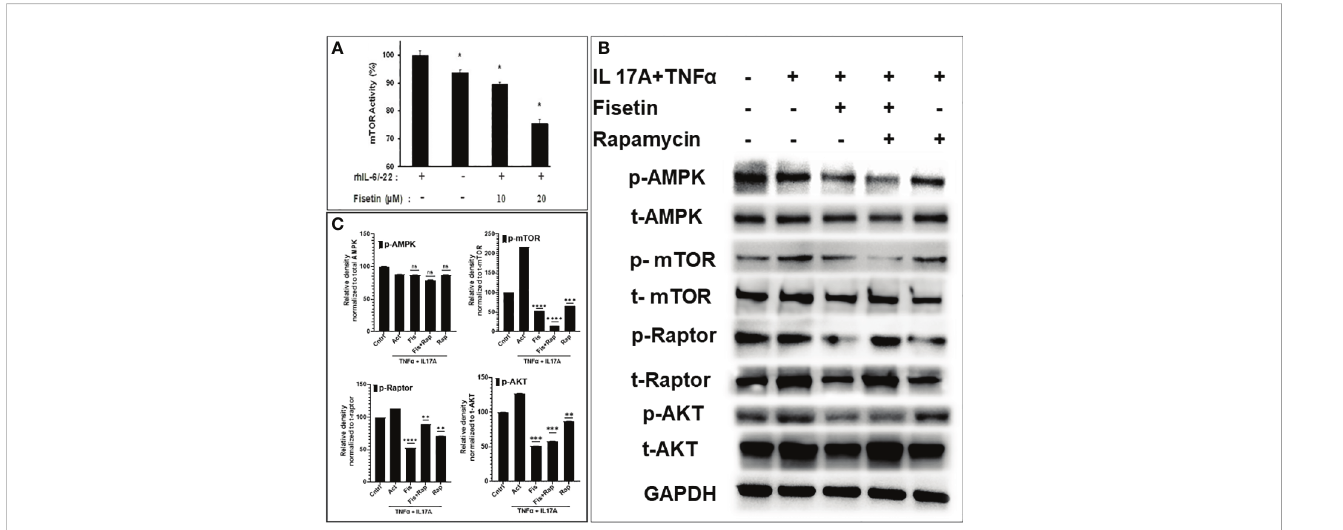
FIGURE 2 Fisetin suppresses mTOR kinase activity and reduces phosphorylated mTOR pathway components in cytokine-activated human epidermal keratinocytes. (A) ELISA analysis of mTOR kinase activity in control, fi setin-treated, or cytokine [rhIL-6/IL-22 (15ng/ml each)]-treated primary keratinocytes lysates. (B) Western blot analysis of differential protein expression levels of p-Akt Ser473 , p-AMPK (Thr 172 )?, p-mTOR Ser2448 , and p-raptor (Ser 792 ) in fi setin (15µM) treated, rapamycin (100nM) or (IL-17A+TNF a )-activated HEKa compared with untreated control cells. (C) Graphs of the semi-quanti fi ed intensity of bands for p-Akt, p-AMPK, p-mTOR, and p-raptor. Bar represents means ± SD of three separate experiments each performed in triplicate. *P < 0.05 , **P < 0.01 , ***P < 0.001 , and ****P < 0.0001 vs. control for IL-6/IL-22-treated only or vs. IL-22 or IL-17A+TNF a for fi setin-treated cells. ns, not signi fi